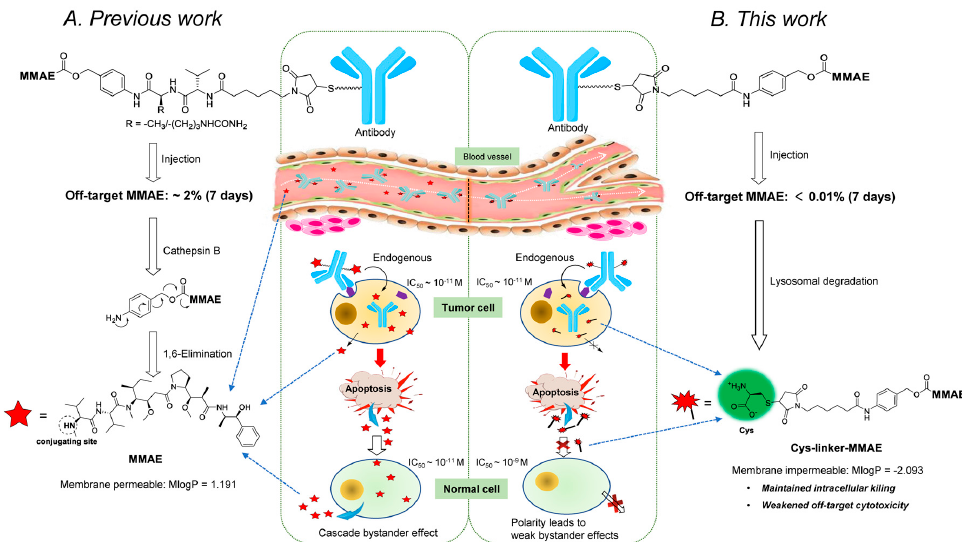
Figure 1. The drug release process of MMAE- and Cys-linker-MMAE-based ADCs. ( A ) The drug release mechanism of traditional MMAE-based ADCs with cathepsin B-cleavable dipeptide linkers. ( B ) The drug release mechanism of the novel Cys-linker-MMAE-based ADC and its cellular metabolites. Cys: L -cysteine; MMAE: monomethyl auristatin E; ADCs: antibody-drug conjugates; IC 50 : half maximal inhibitory concentration; M: mol/L; MlogP: Moriguchi octanol-water partition coefficient.